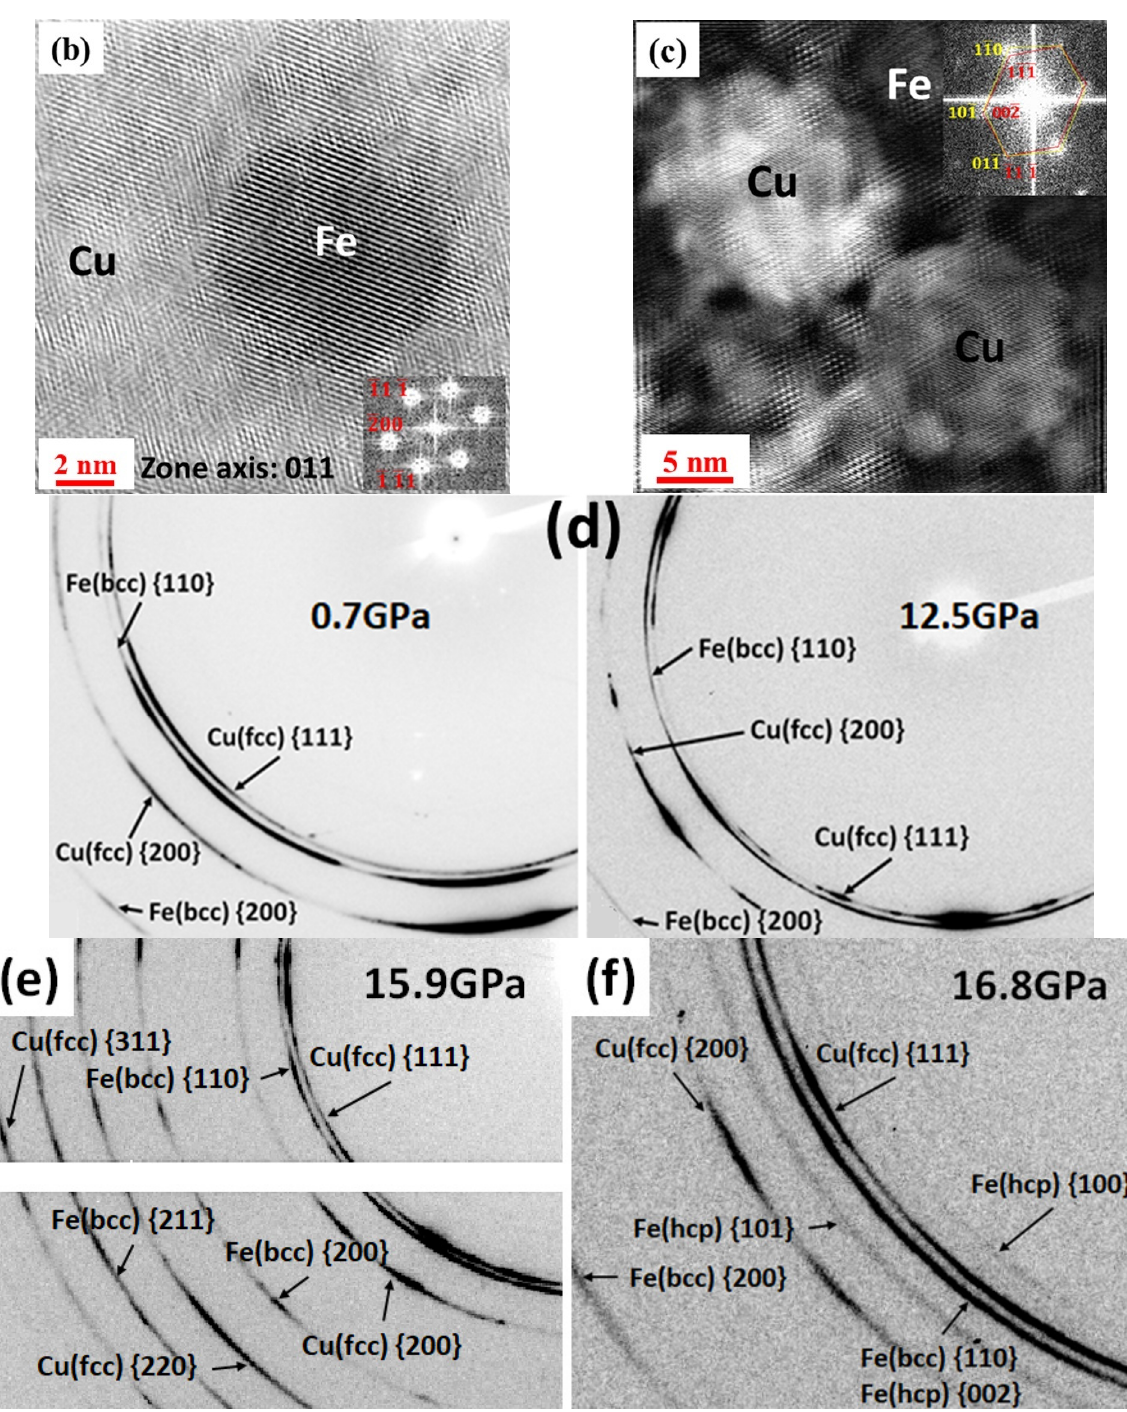
Figure 3. ( a ) SEM micrograph showing two phase-separated regions of Cu and Fe (i.e., Cu grain and Fe grain ) and the presence of precipitates (i.e., Cu ppt and Fe ppt ) formed during the laser DMD process. HAADF-STEM micrographs exhibiting ( b ) coherent Fe precipitate (FCC structure) in Cu matrix and ( c ) Cu precipitate (FCC structure) in Fe grain. ( d ) Diffraction patterns obtained on Cu and Fe matrices of Cu50Fe50 precipitates with X-ray monochromatic beam at 16BMD beamline of APS. The left-hand-side pattern indicates a beam size of 5 × 3.5 µm 2 with no sample rotation, while the right-hand-side pattern indicates a beam size of 4 × 4.5 µm 2 with sample rotated by 50°. Diffraction patterns showing ( e ) no presence of Fe (HCP) at 15.9 GPa pressure, ( f ) and the presence of Fe (HCP) at 16.8 GPa.